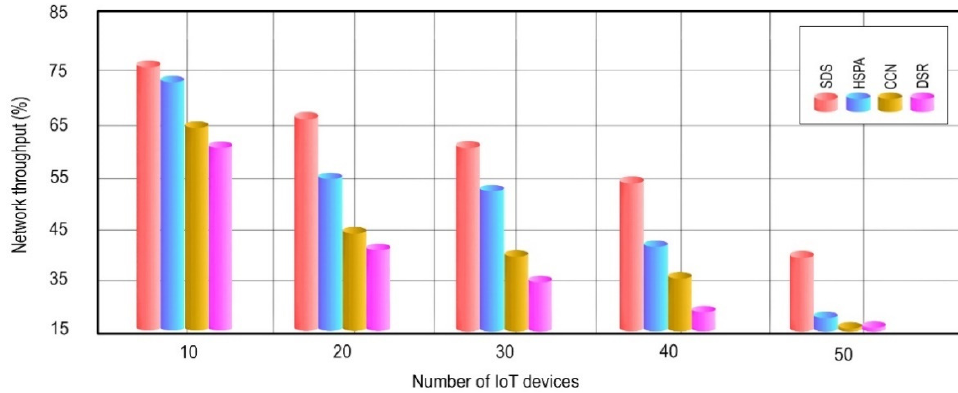
Figure 5. Proposed SDS network throughput.